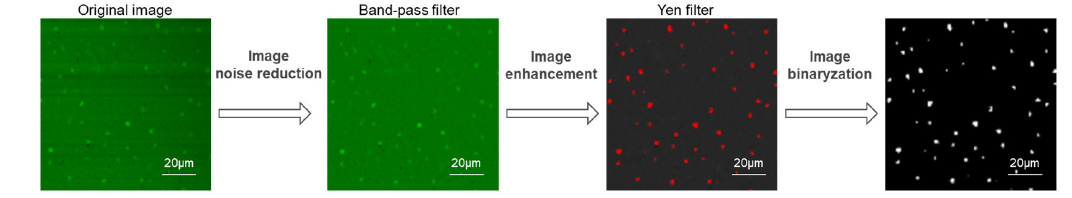
Figure 4. Image process steps for CLSM images.